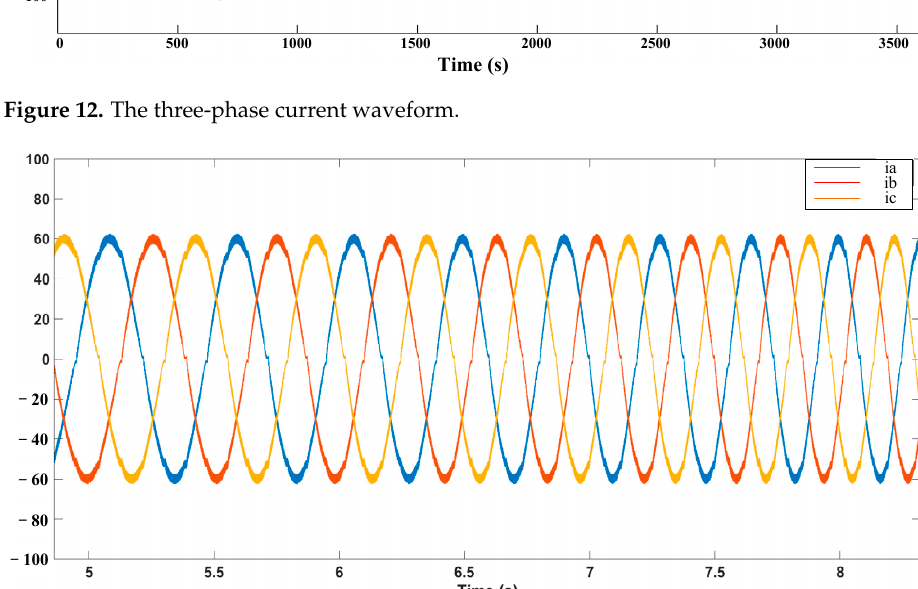
Figure 13. The enlarged part of the current waveform.